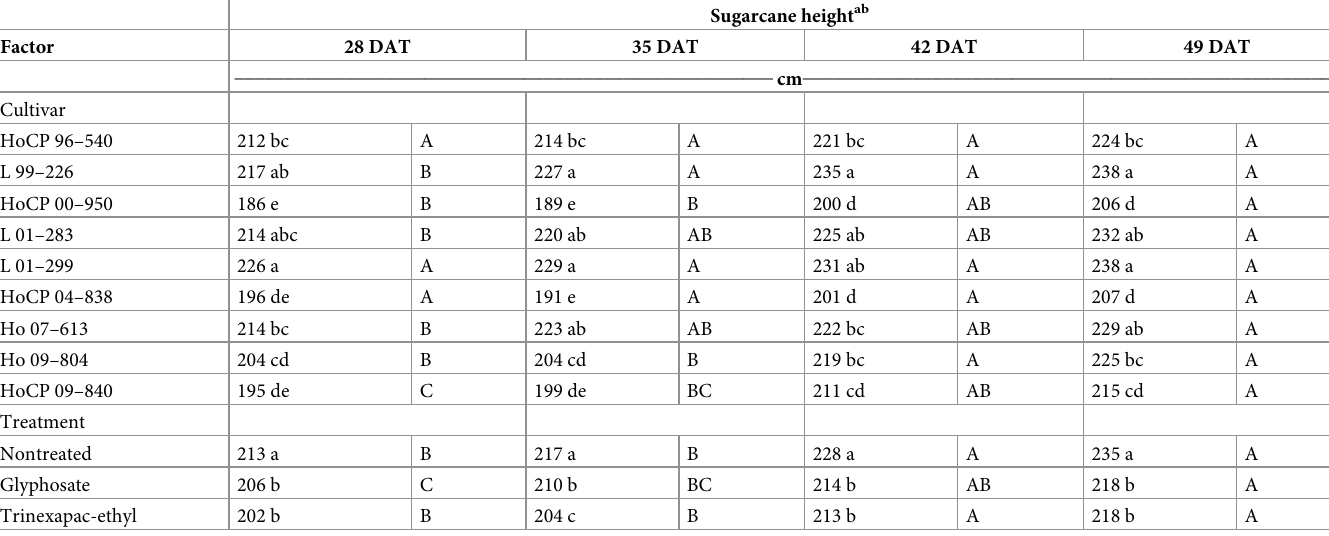
a Sugarcane stalks were measured from the base of the plant to the last fully expanded internode. b Means within cultivar and treatment that are followed by the same lower case letter and means within DAT that are followed by the same upper case letter are not significantly different according to Tukey HSD